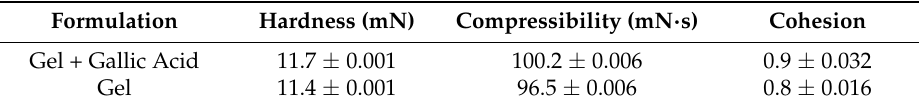
Table 4. Mechanical properties (hardness, compressibility, and cohesiveness) of both gel (gel) and GA-loaded gel (gel + gallic acid). Each value represents the mean ( ± SD) of at least seven replicates at 25 ◦ C.